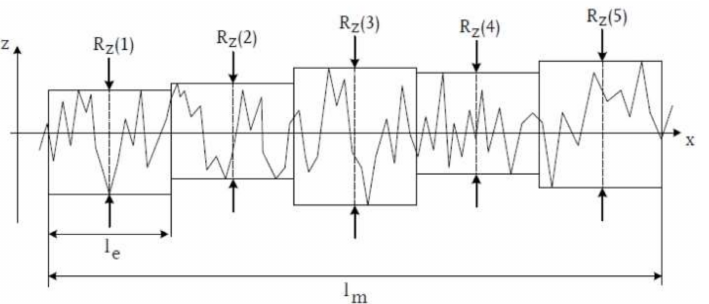
Figure 7. The distance between two parallels to the middle line is the individual peak-to-valley height that meets the maximum or minimum of the roughness profile within the individual measurement section. Thus, the surface roughness Rz is a measure of the average vertical surface fissures. (Rz is determined from the arithmetic mean of the individual roughness depths Z1 - Z5 of five consecutive individual measuring sections. The z axis shows the roughnesses, the x axis shows the